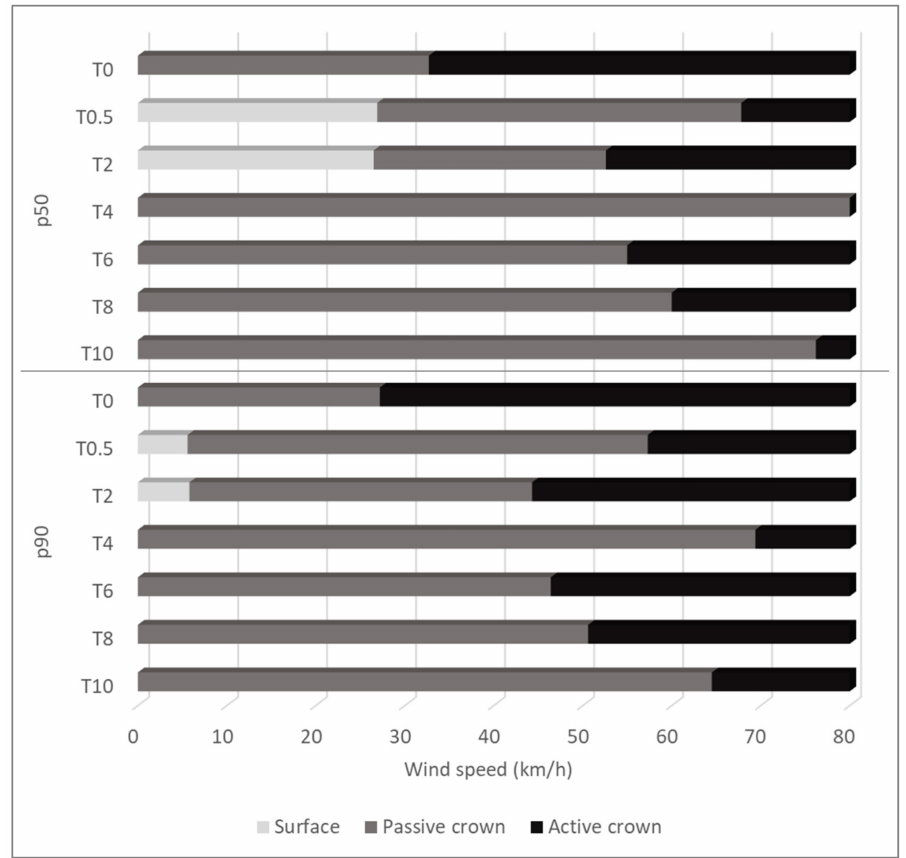
Figure 3. Expected fire type depending on the time since treatment, weather scenarios, and wind